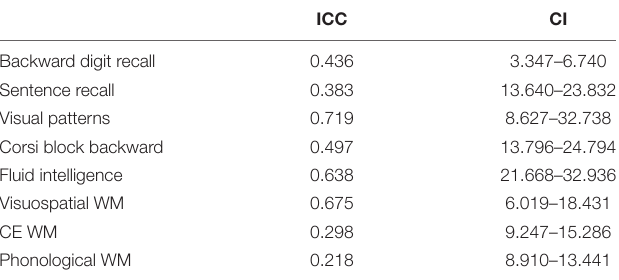
TABLE 4 | Intra-class correlation coefficient (ICC) and Confidence Intervals for the performance on fluid intelligence test, the phonological working memory measures, and the visuo-spatial working memory